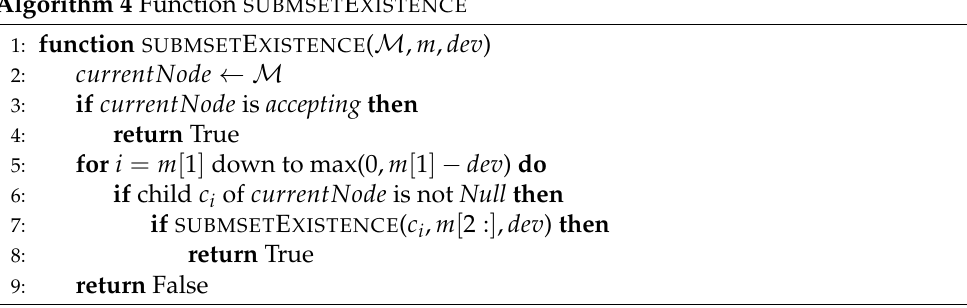
Algorithm 4 Function SUBMSET E